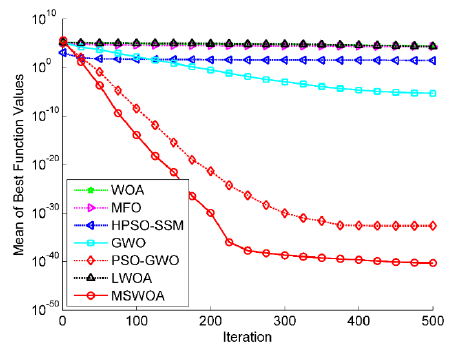
Figure 4. Optimization results for F1 (Dim = 30).